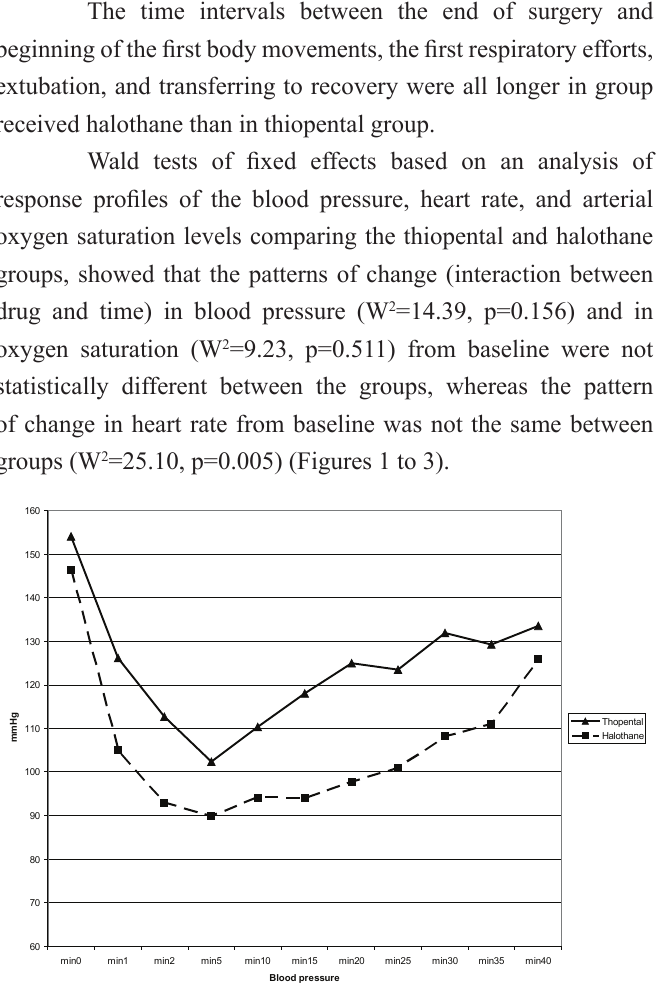
FIGURE 1 - Blood pressure after the administration of thiopental and